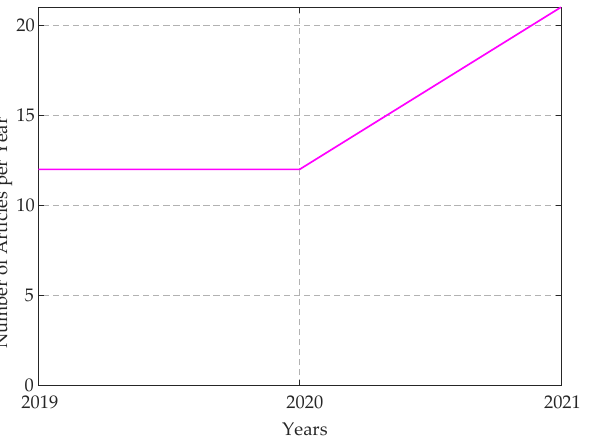
Figure 1. An analysis of the recently published research articles in the field of TSN. ( a ) Number of articles per year on Scopus. ( b ) Number of articles published on conferences or journals belonging to the I&M and industrial fields on Scopus.